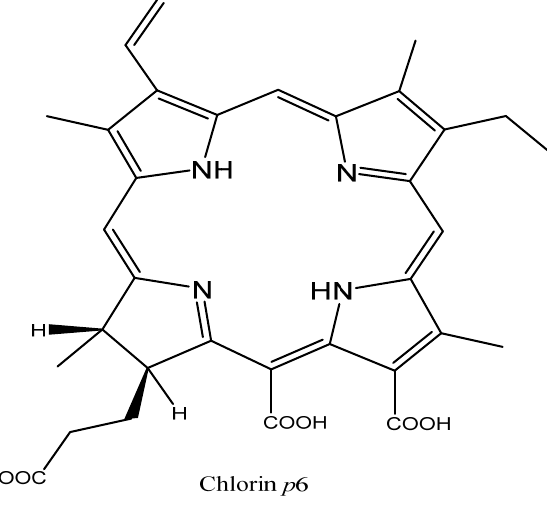
Figure 7. Chemical structure of chlorin p6 [75].